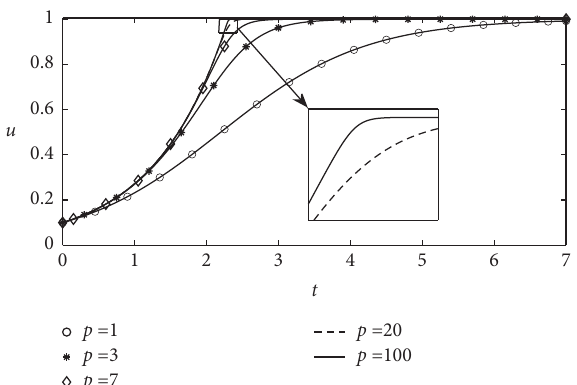
Figure 8: Evolution of u with p � 1 , 3 , 7 , 20, and 100, Δ t � 0 . 0001, and t � 7.